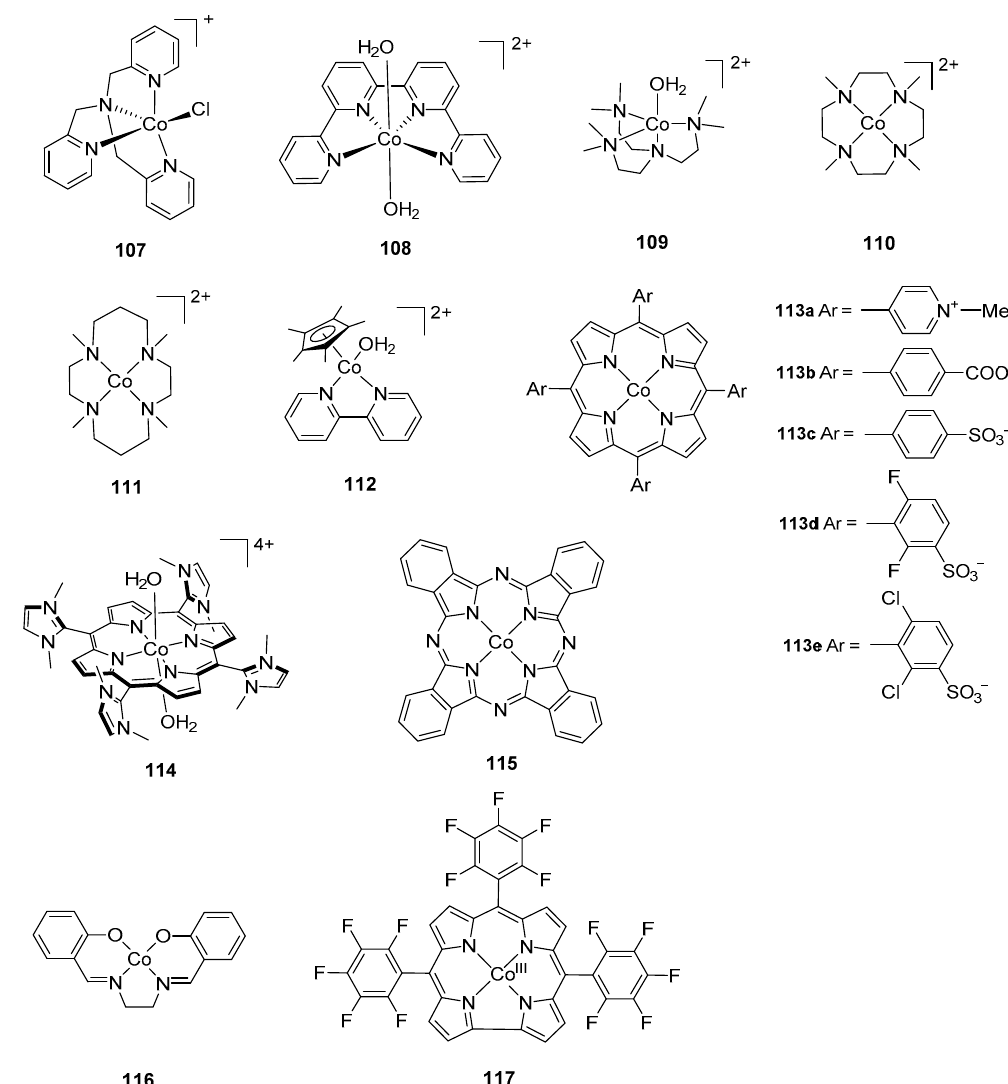
Figure 8. Selected cobalt complexes 96–117 for water oxidation: [Co 4 O 4 ( μ -OAc) 4 (py) 4 ] ( 96 , py = pyridine) [143]; [Co 4 ( μ - O)4( μ -OAc)4( p -pyX) 4 ] ( 97a – 97f , py = pyridine, X = Me, t -Bu, OMe, Br, COOMe, CN) [166]; [(TPA)Co( μ -OH)( μ